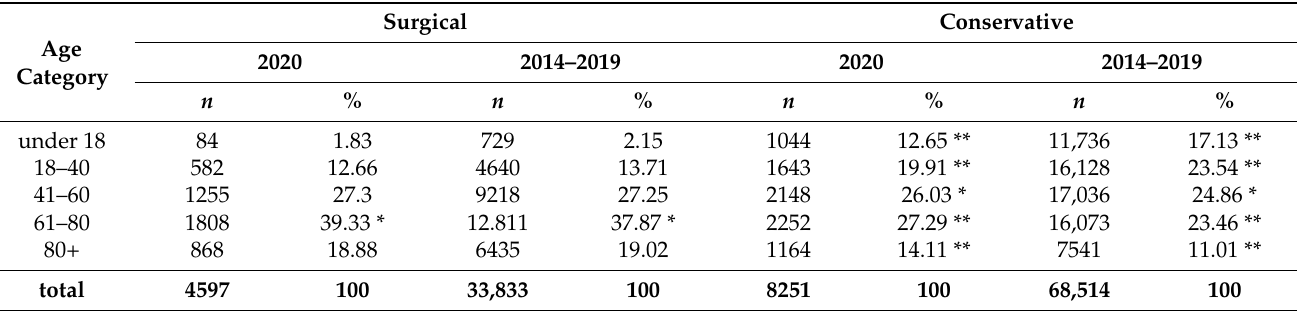
Table 3. Age of patients treated due to TBI between the pre-COVID-19 period and 2020. * p < 0.05, ** p <